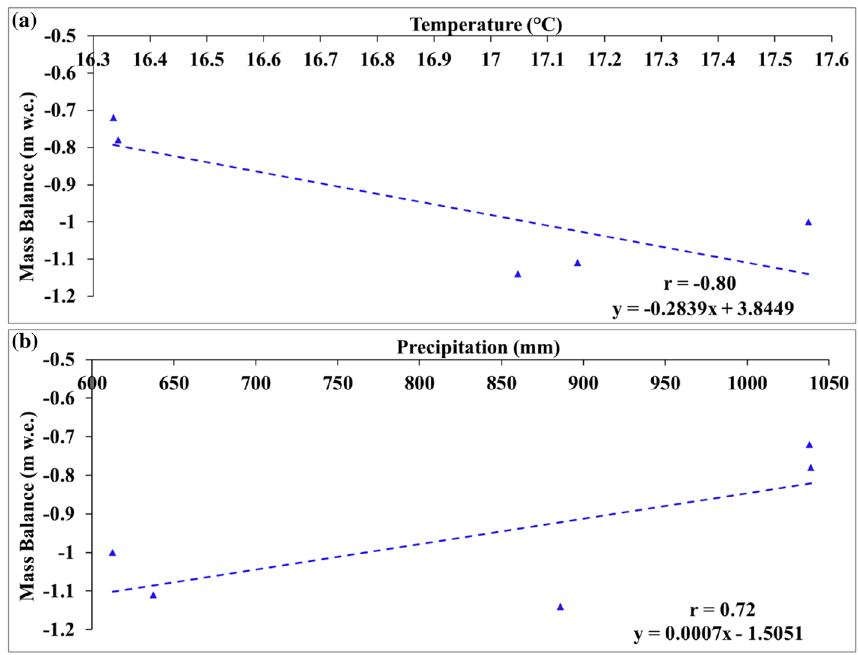
Figure 6. Correlation of the observed annual mass balance with ( a ) annual summer temperature and ( b ) annual winter precipitation from 2013 to 2018.